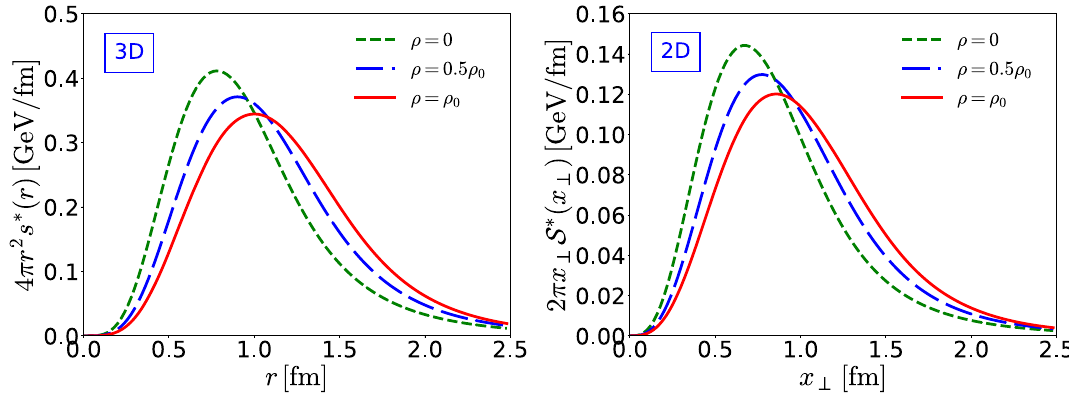
Fig. 7 3D and 2D pressure distributions of the nucleon as functions of the nuclear density ρ , multiplied by 4 π r 2 and 2 π x ⊥ , respectively. Notations are the same as in Fig.